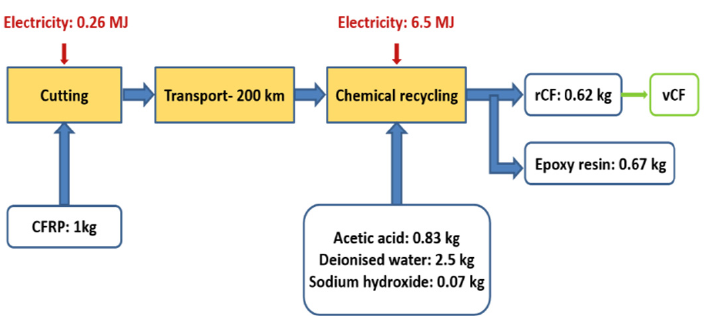
Figure 17. Flow diagram of chemical recycling.